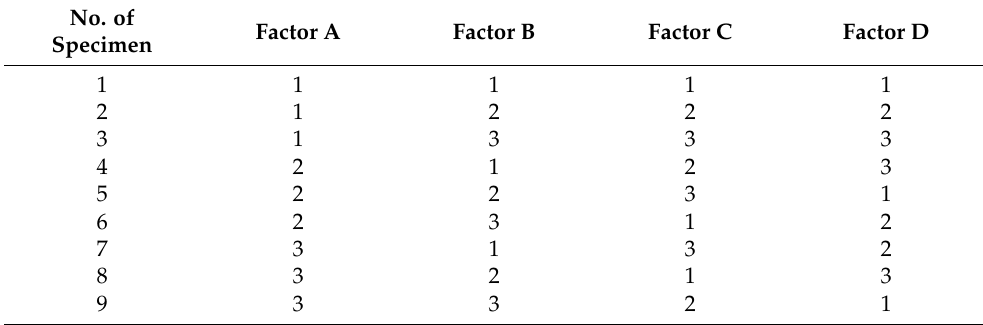
Table 1. L 9 (3 4 ) orthogonal table for the design of